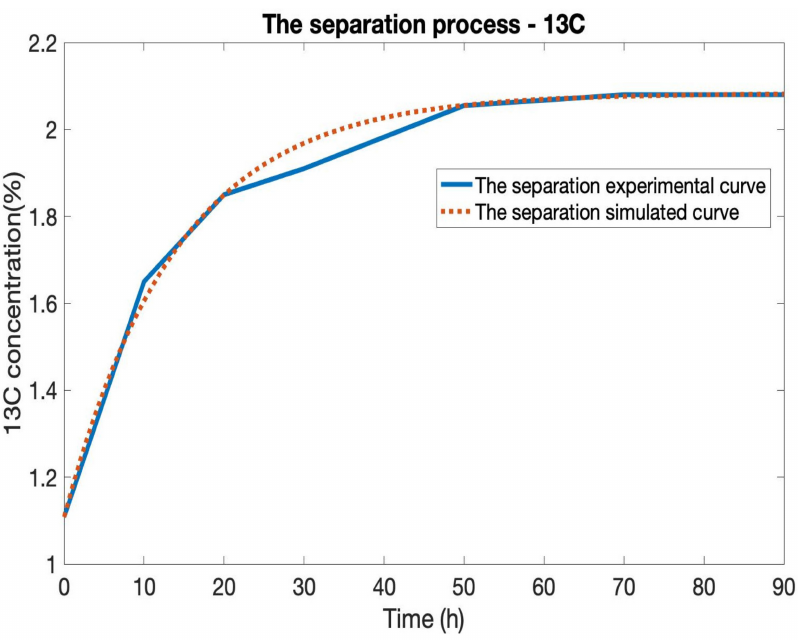
Figure 2. The separation process experimental curve and the most probable approximating response of the separation process.